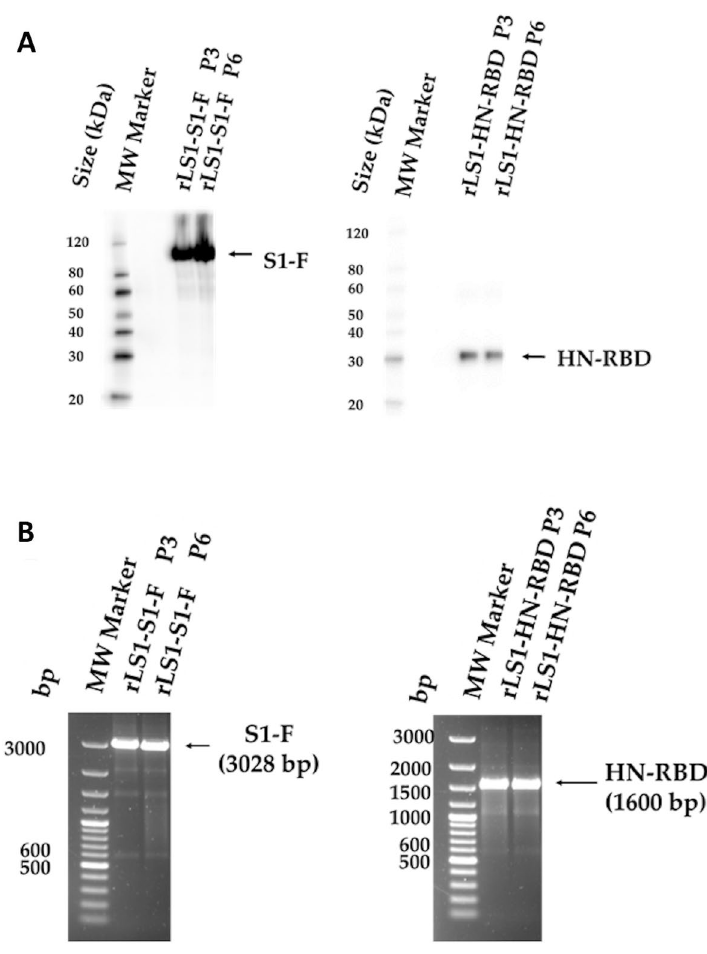
Figure 3. Genetic stability of the recombinants. The genetic stability of the rLS1-HN-RBD, and rLS1-S1-F viruses was evaluated at the 3rd and 6th passages by ( A ) Western blot analysis using a rabbit polyclonal antibody specific to SARS-CoV-2 RBD protein, and ( B ) RT-PCR using the primers NDV-3LS1-2020-F1 and NDV-3LS1- 2020-R1 to amplify the complete inserts. P3: 3rd passage, P6: 6th passage. Black arrow indicates the expected molecular